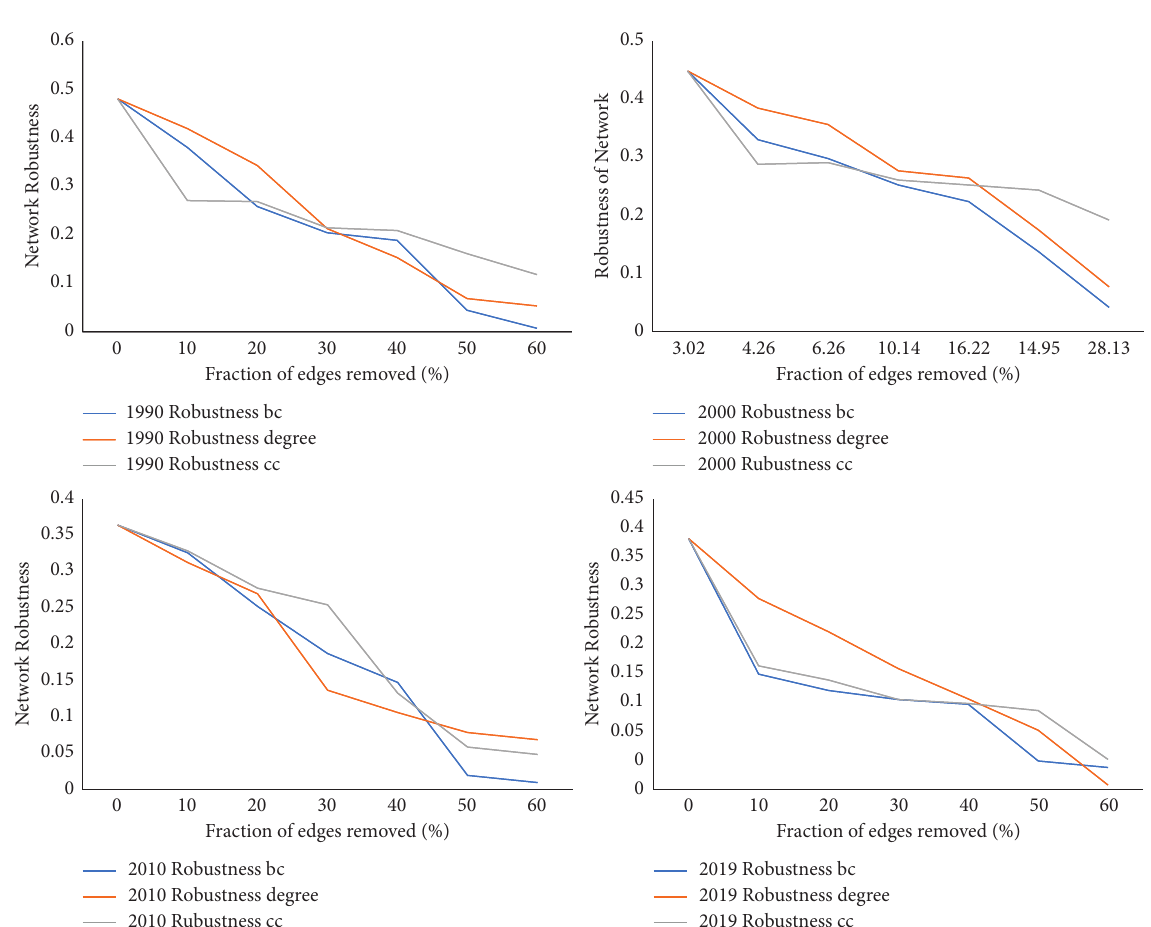
Figure 5: Evolution of USACN robustness under attacks based on centrality values from 1990 to 2019.